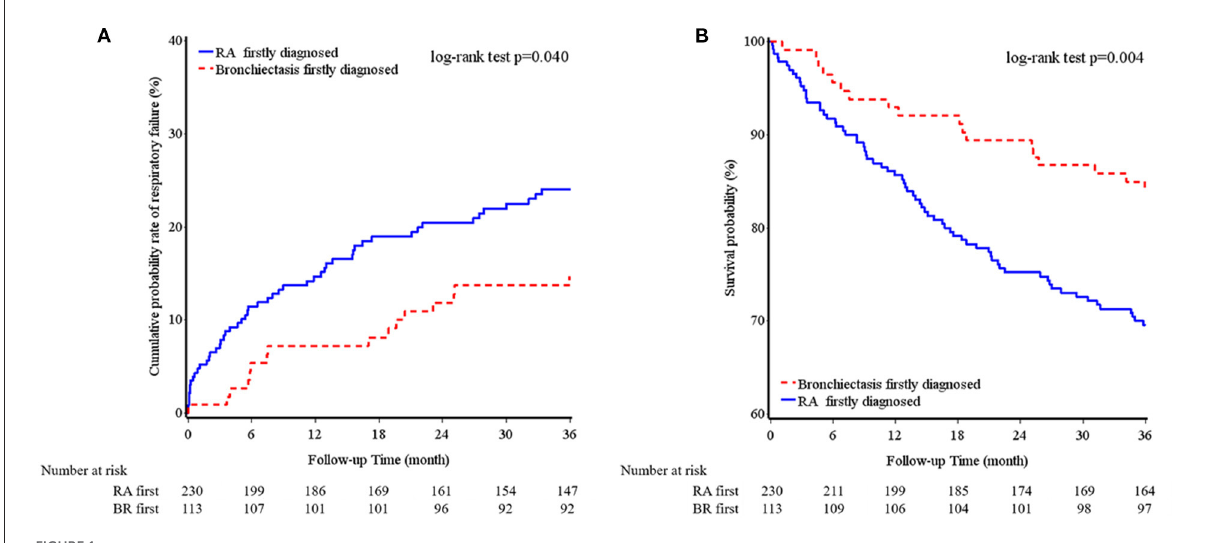
FIGURE1 Cumulative incidence of respiratory failure (A) and overall survival (B) of bronchiectasis and rheumatoid arthritis chronology within a 3-year follow-up period.